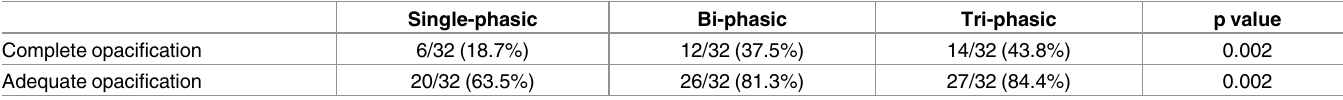
Footnote; Data show the number of patients. Data in parentheses are percentage of patients. Complete and adequate opacification indicate 100% and more than 75% opacification, respectively. Data of single- and bi-phasic excretory phase are the best results obtained among each group